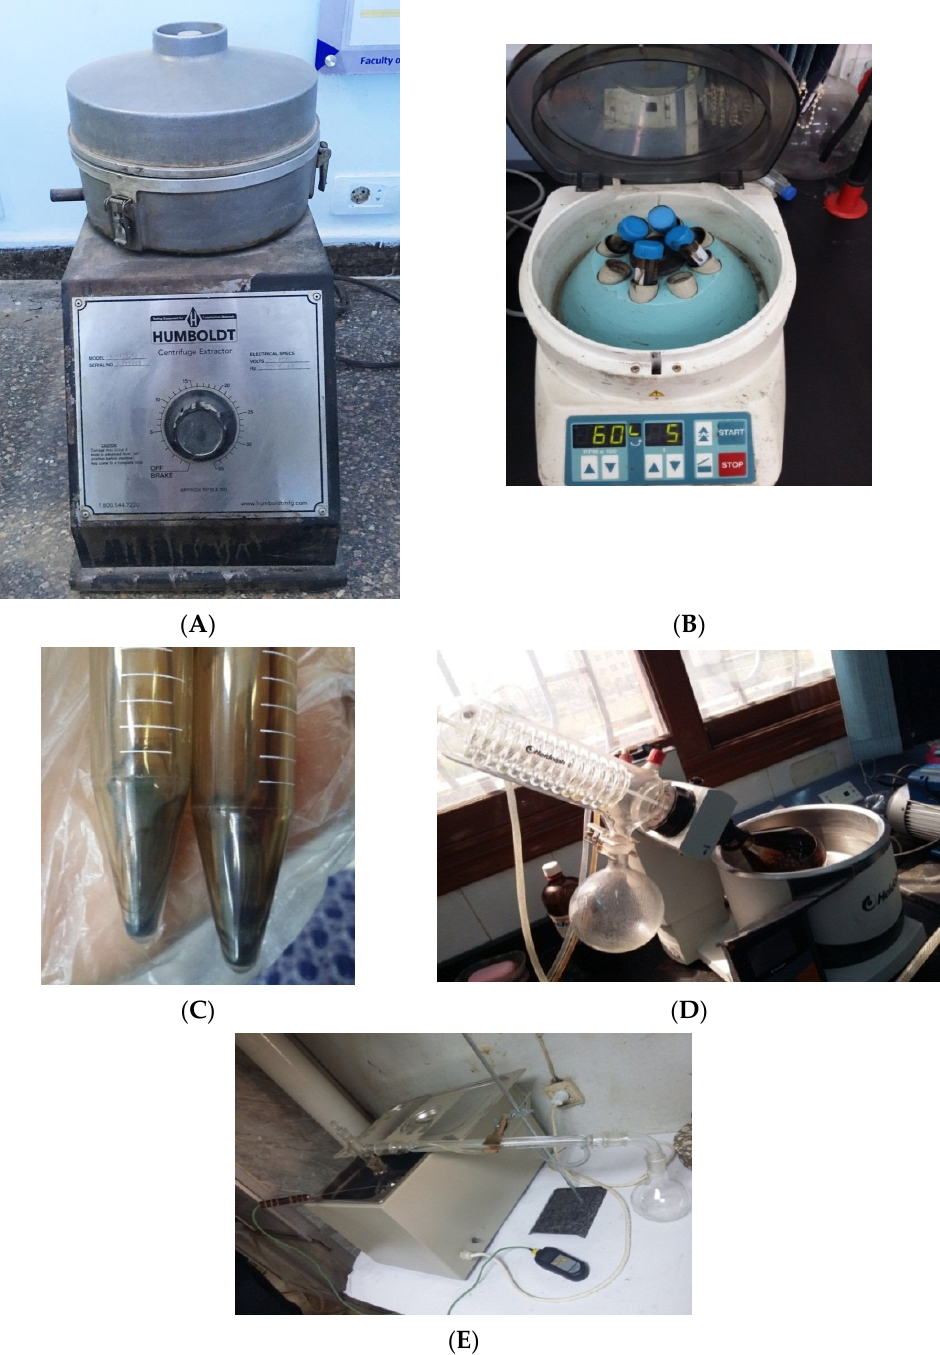
Figure 2. Extraction, distillation, recovery, and centrifugation. ( A ) Extraction device, ( B ) centri- fuge, ( C ) impurities resulting from the centrifugation, ( D ) rotavapor distillation, and ( E ) column